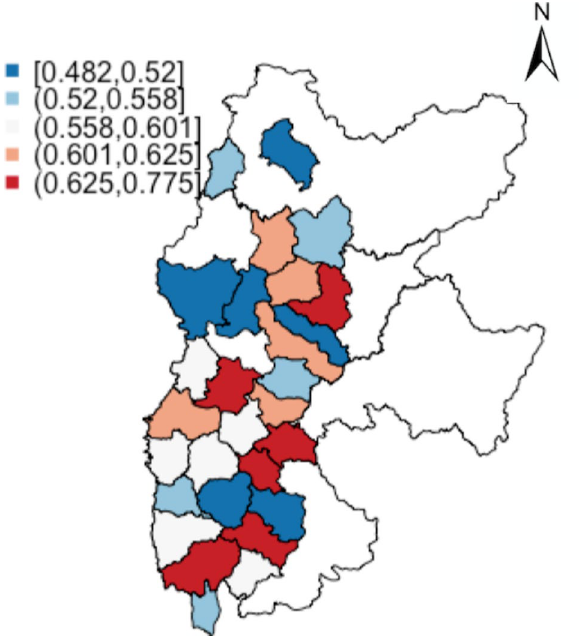
Figure 12. Lower administrative areas with high risk of collapsibility.